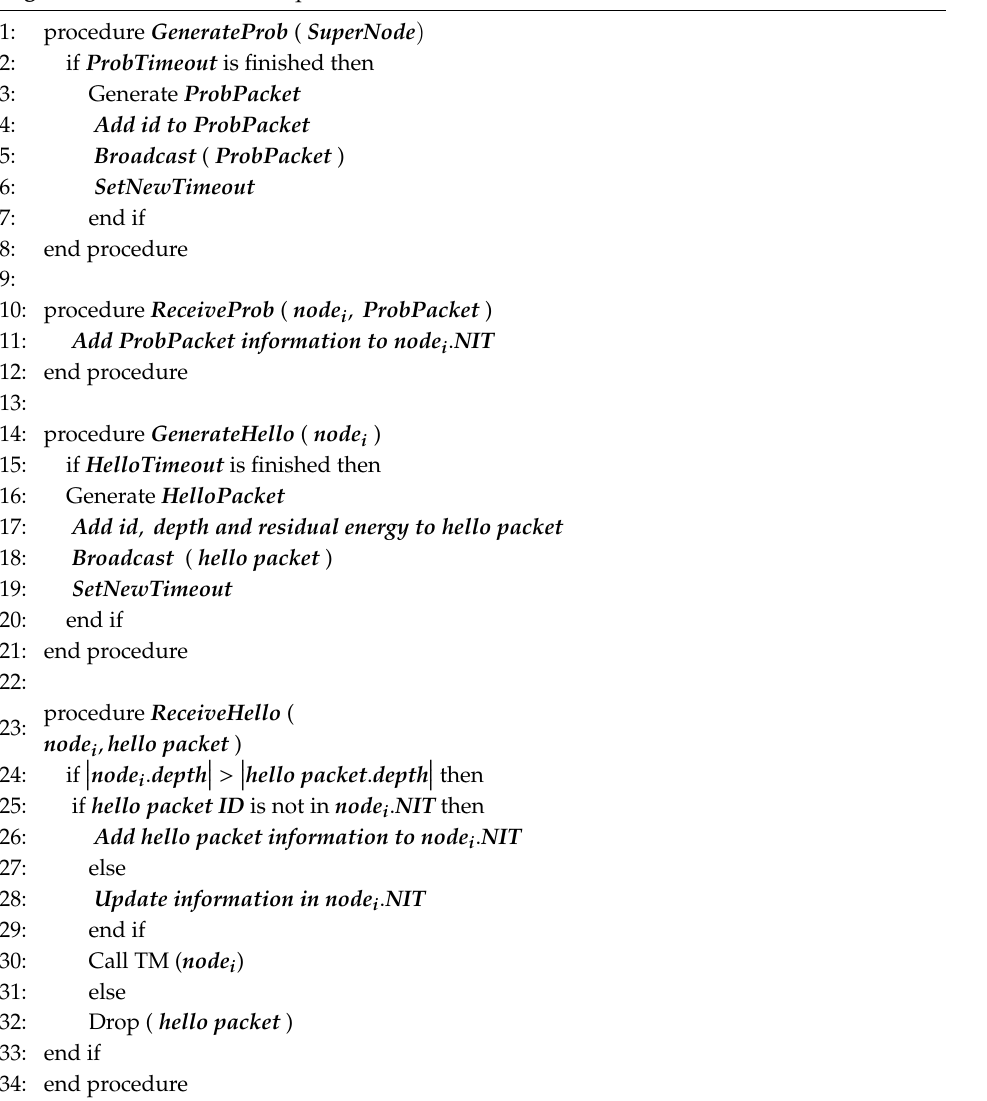
Algorithm 1. Information Acquisition